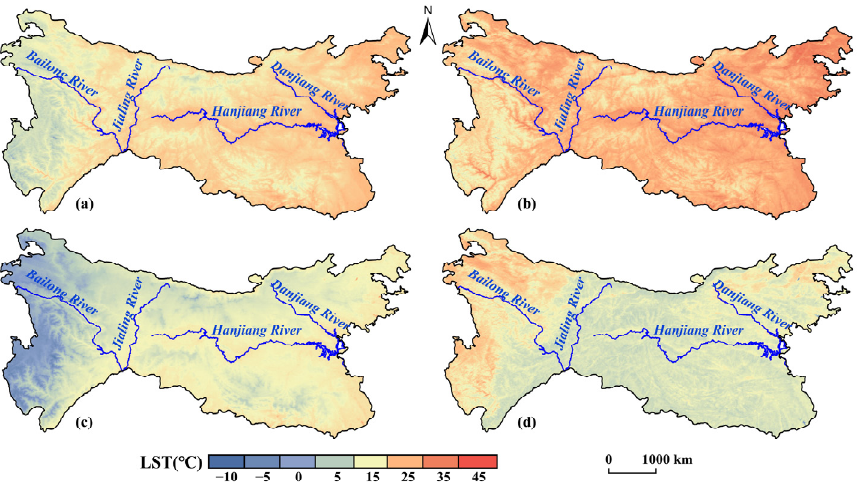
Figure 2. Spatial distribution of LST in the Qinling-Daba Mountains from 2000 to 2020: ( a ) average annual LST; ( b ) daytime LST; ( c ) nighttime LST; and ( d ) DIF.